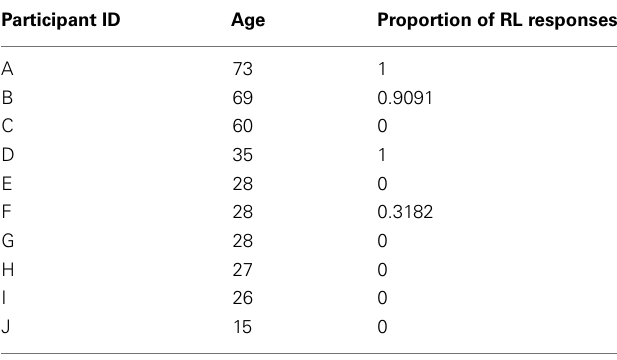
Table 4 | Proportion of RL